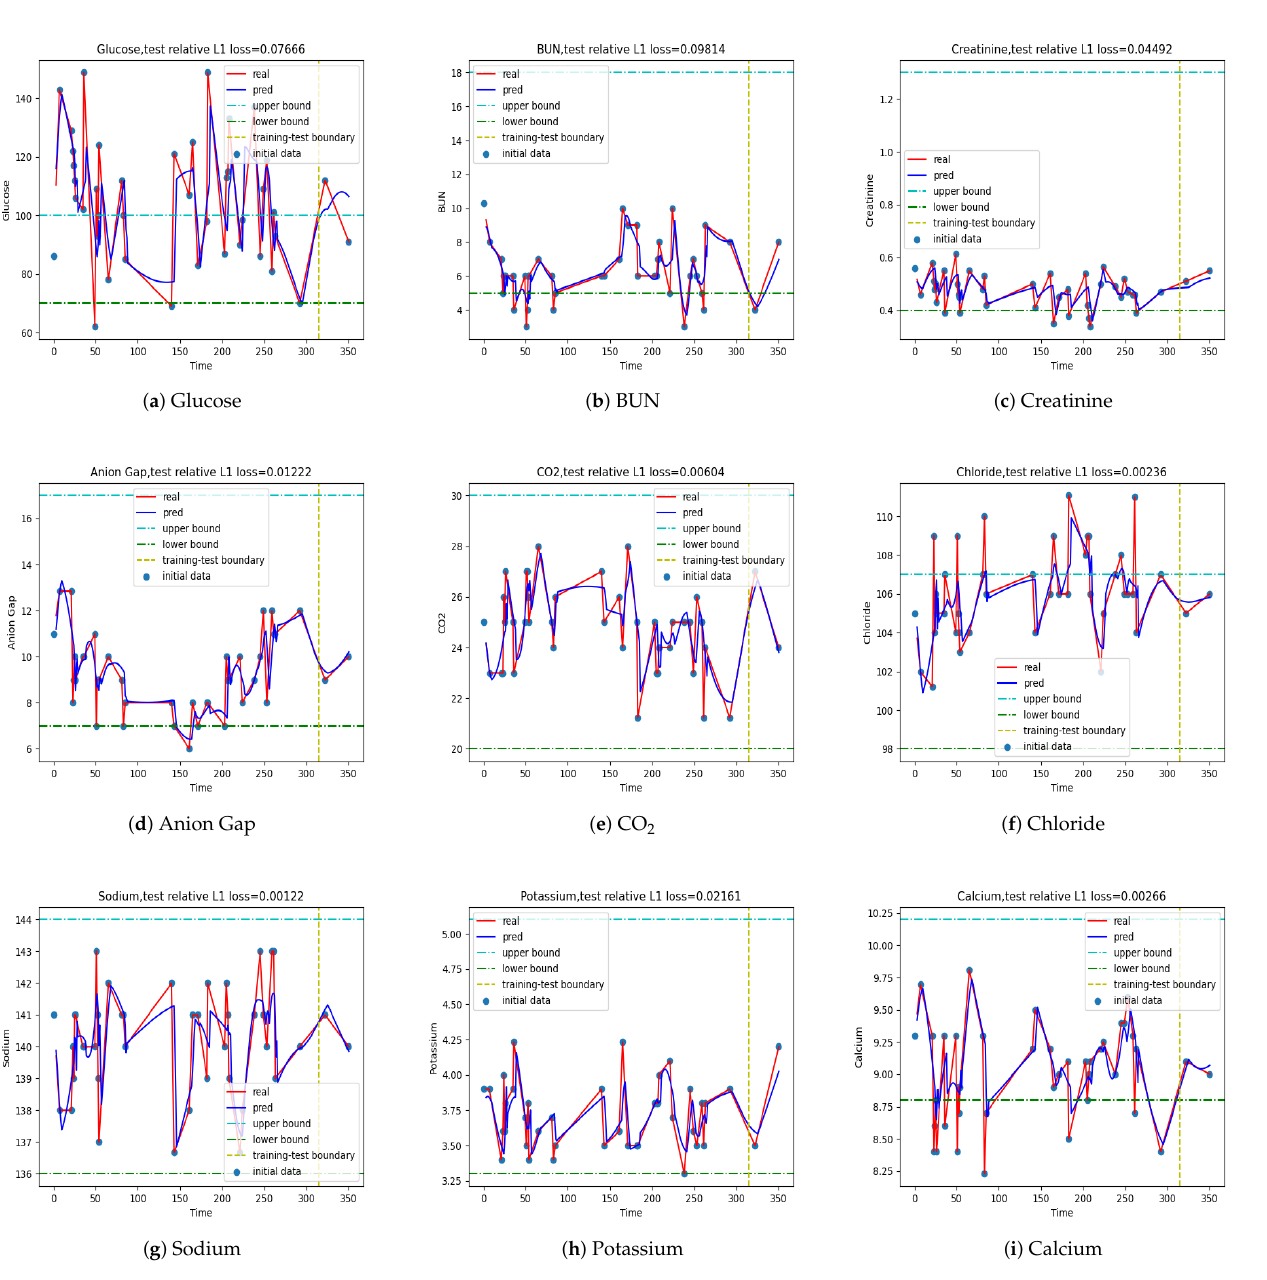
Figure 8. Multi-step predictions of the LSTM model for patient ESK at T = 1, L = 3. The values on the right of the vertical line are